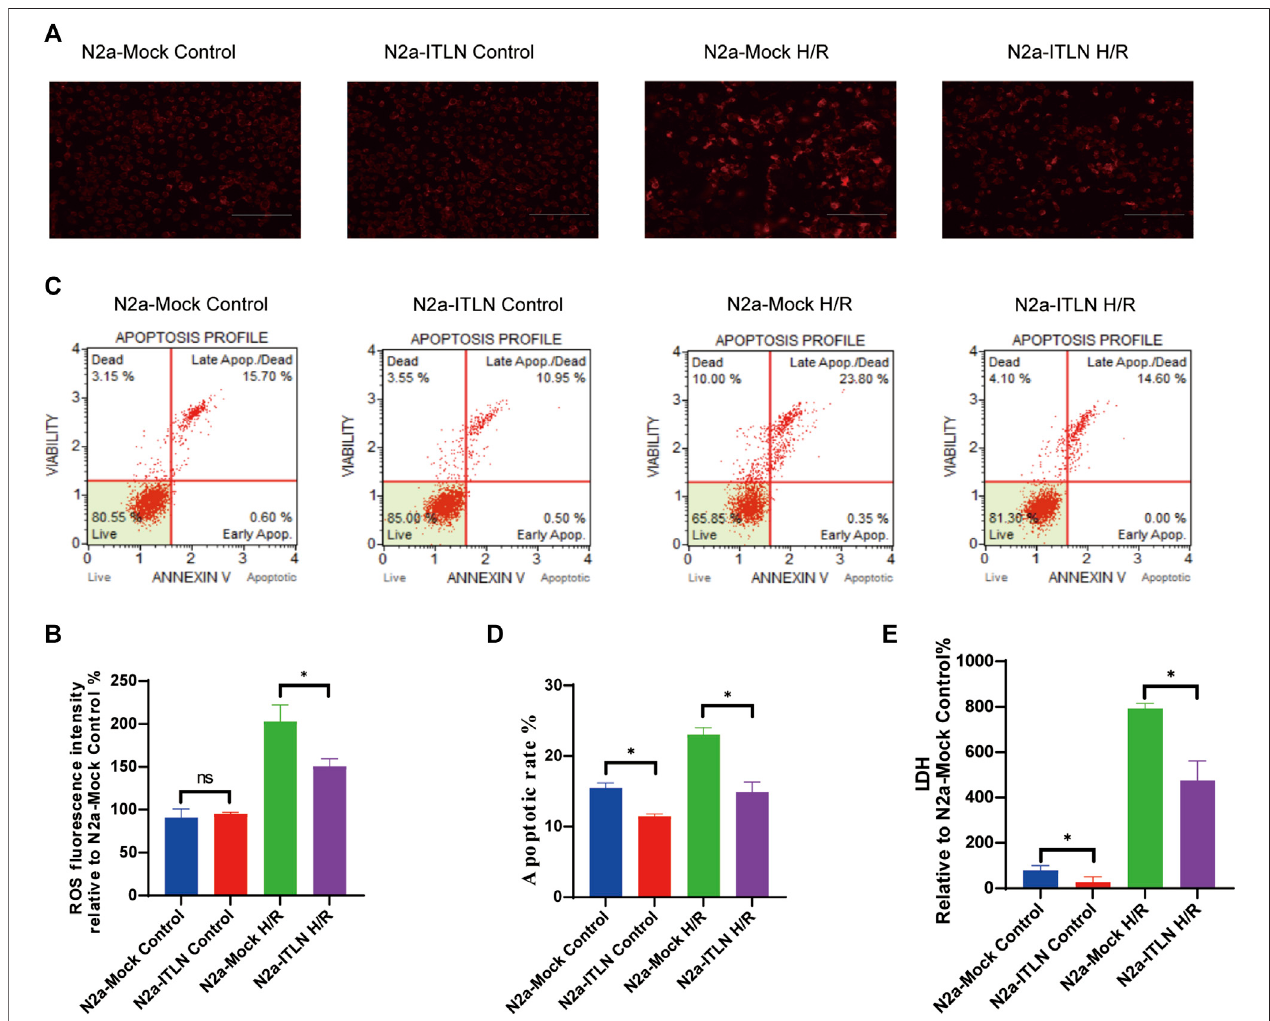
FIGURE 9 | Omentin-1 overexpression inhibited H/R-induced LDH release, intracellular ROS generation, and cellular apoptosis. (A) Intracellular ROS levels of H/ R-induced injury in lentivirus-infected N2a cells. (B) Statistical graph of intracellular ROS levels. (C) Apoptotic analysis of H/R-induced injury in lentivirus-infected N2a cells. (D) Statistical graph of apoptotic rates. (E) LDH release of H/R-induced injury in lentivirus-infected N2a cells. ITLN (cid:2) Omentin-1. Error bars show the standard deviation for n (cid:2) 6 measurements from representative experiments. * p < 0.05 vs. the N2a-Mock group; ns, non-signi fi cant.